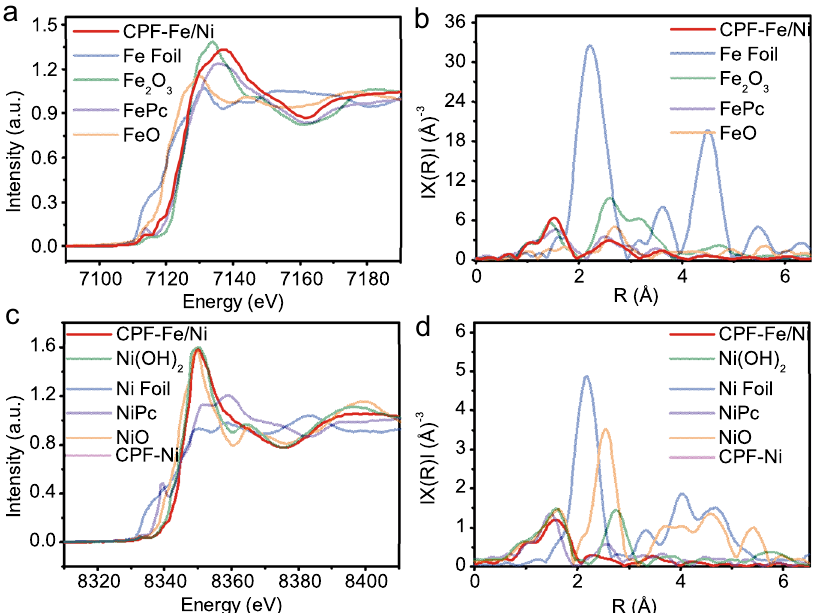
Fig. 2 | The synchrotron-based XANES and the extended X-ray absorption fi ne structure (EXAFS) spectra. a Normalized XANES and b radial structure functions (RSFs) of the Fe K-edge obtained by Fourier transformation k 3 -weighted EXAFS results, withthe Fe foil,Fe 2 O 3 ,Fe 3 O 4 , and FePcservingasreferences; c Normalized